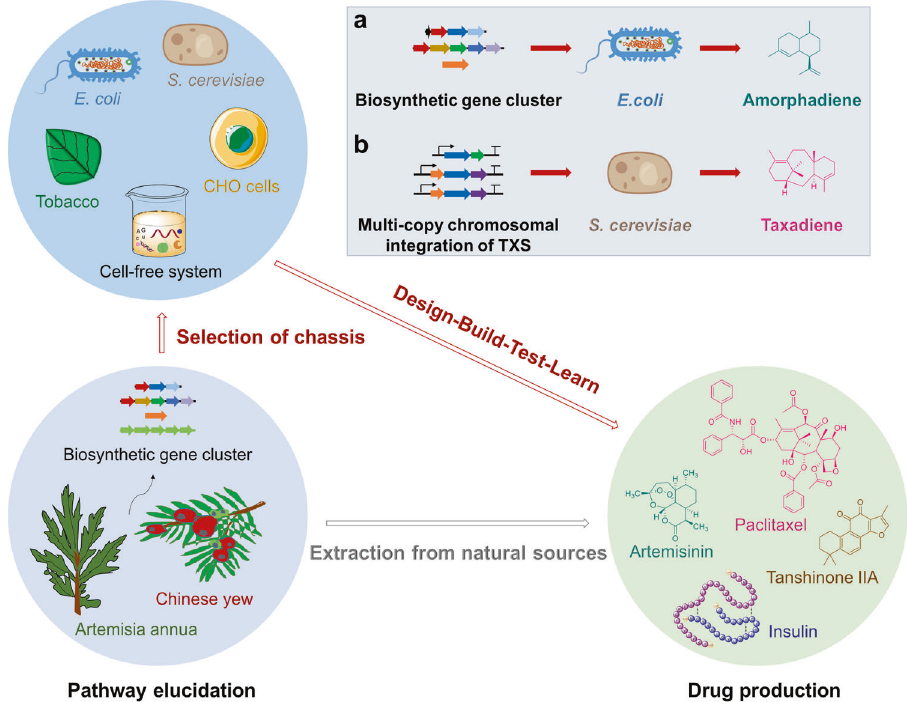
Fig. 6 Synthetic biology facilitates drug production in diverse chassis systems. Outlined scheme of the typical pipeline of drug development consisting of pathway elucidation, chassis selection and drug production. Gray arrow indicates extraction of bioactive compounds from natural sources, red arrows indicate general synthetic biology pathways. a Synthetic biology production of amorphadiene in E. coli chassis. b Synthetic biology production of taxadiene in S. cerevisiae